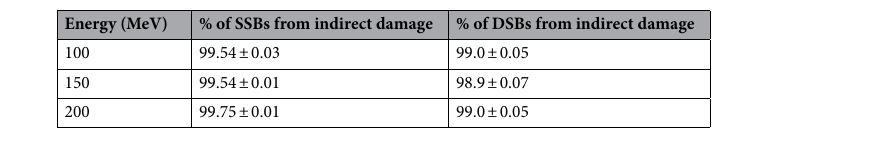
Table 4. Percentage of total DNA damage caused by indirect radiation effects for SSBs and DSBs.